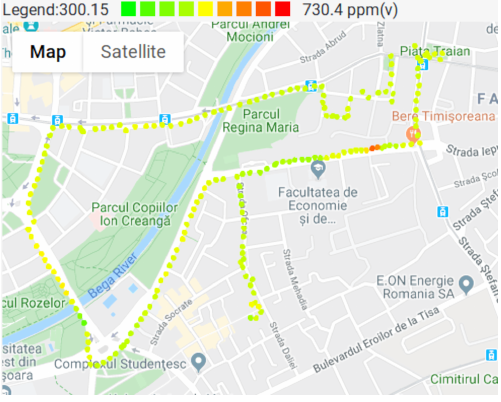
Figure 8. CO 2 measurements.